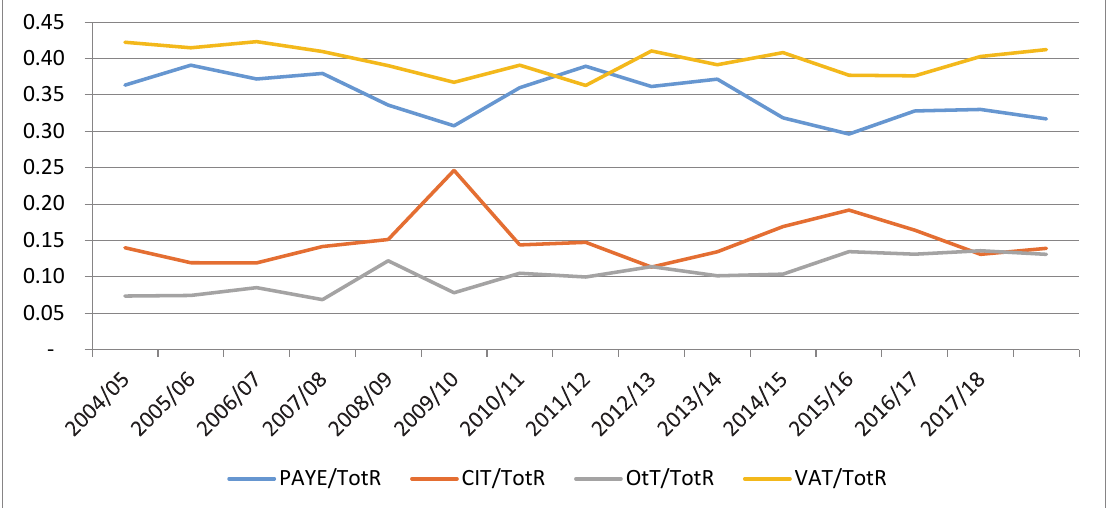
Fig. 2. Contribution of different tax types to Total revenue from 1992-2017